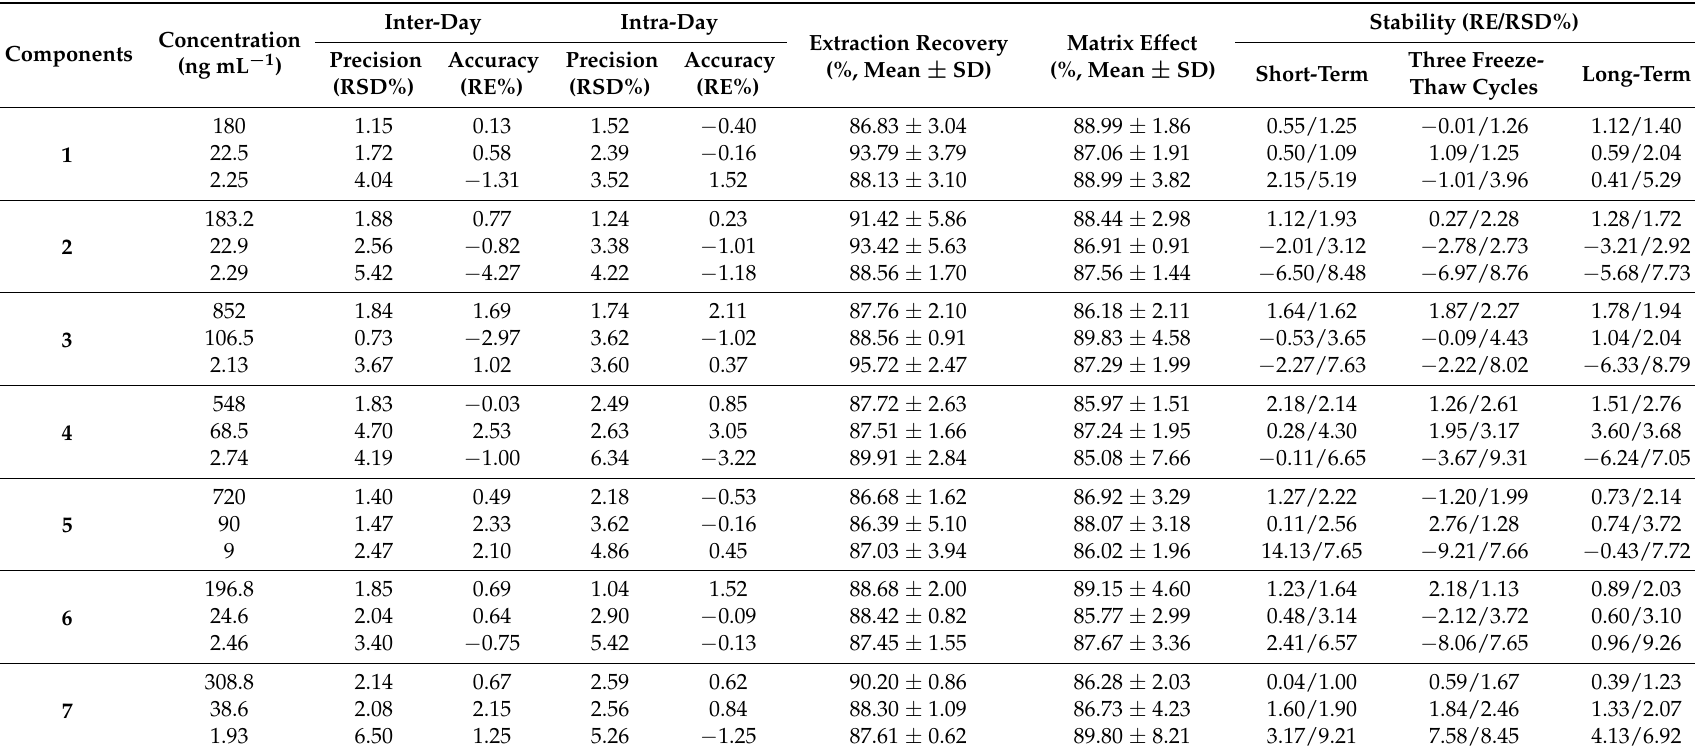
Table 3. Precision, accuracy, extraction recovery, matrix effect, and stability of the seven components in rat plasma samples ( n = 6).